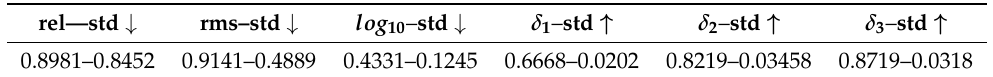
Table 6. Performance about quantitative metrics in GAN and its standard deviation in 50 samples. Where ↓ Low is better, and ↑ Up is better.